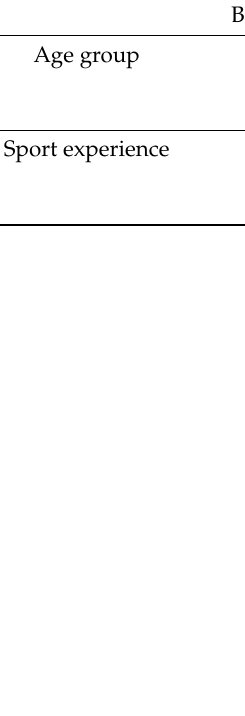
Table 3. Group difference statistics by categorical variables for the PNPCAP negative